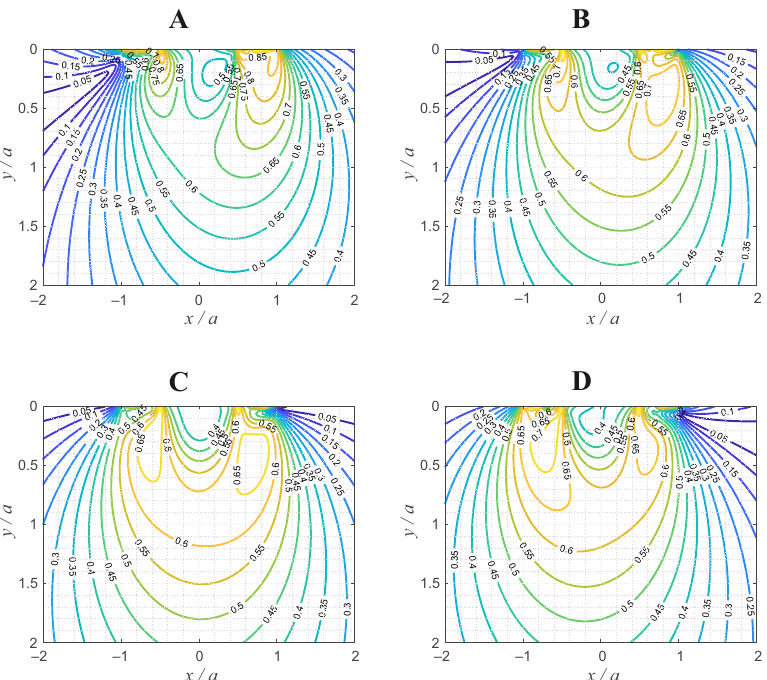
Figure 5. Contour line diagram of the equivalent von-Mises stress, normalized for the average contact pressure P / ( 2 a ) , in the oscillating tangential contact with a truncated cylinder, as a function of x / a and y / a , for b = 0.5 a , Q max = 0.6 µ P , µ = 0.5 and ν = 0.3; for the points ( A ), ( B ), ( C ), and ( D ) of the loading diagram in Figure 4 (each subfigure corresponds to the respective point in the loading diagram).